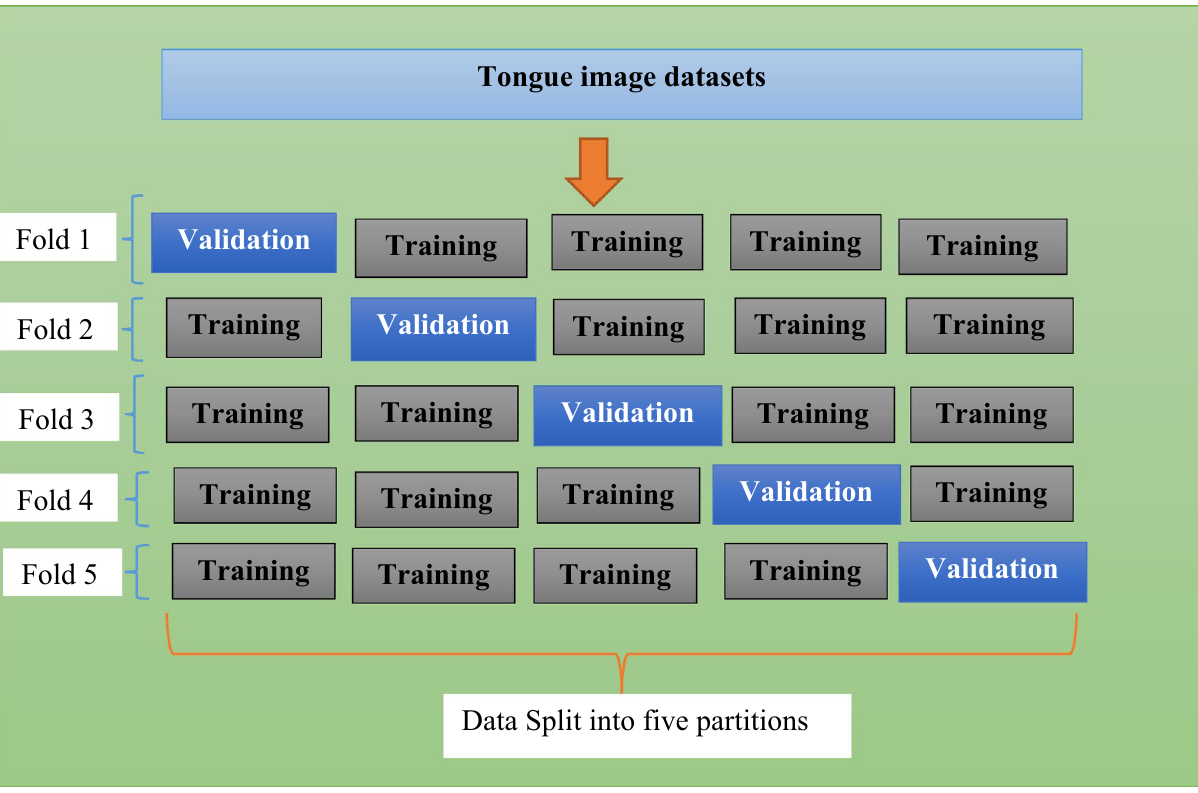
Figure 8. Fivefold cross validation for diagnosis of diabetes mellitus.